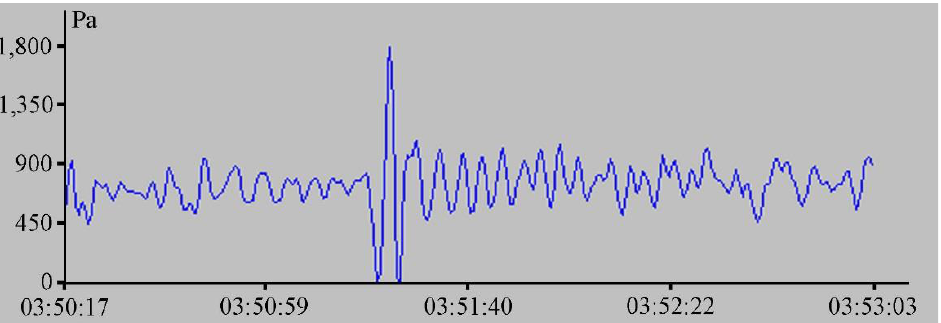
Figure 3. A recording section of the supersensitive detector of hydrosphere pressure variations for 29 September 2020, installed on the seabed at a depth of 4 m in Alekseev Bay, Popov Island.